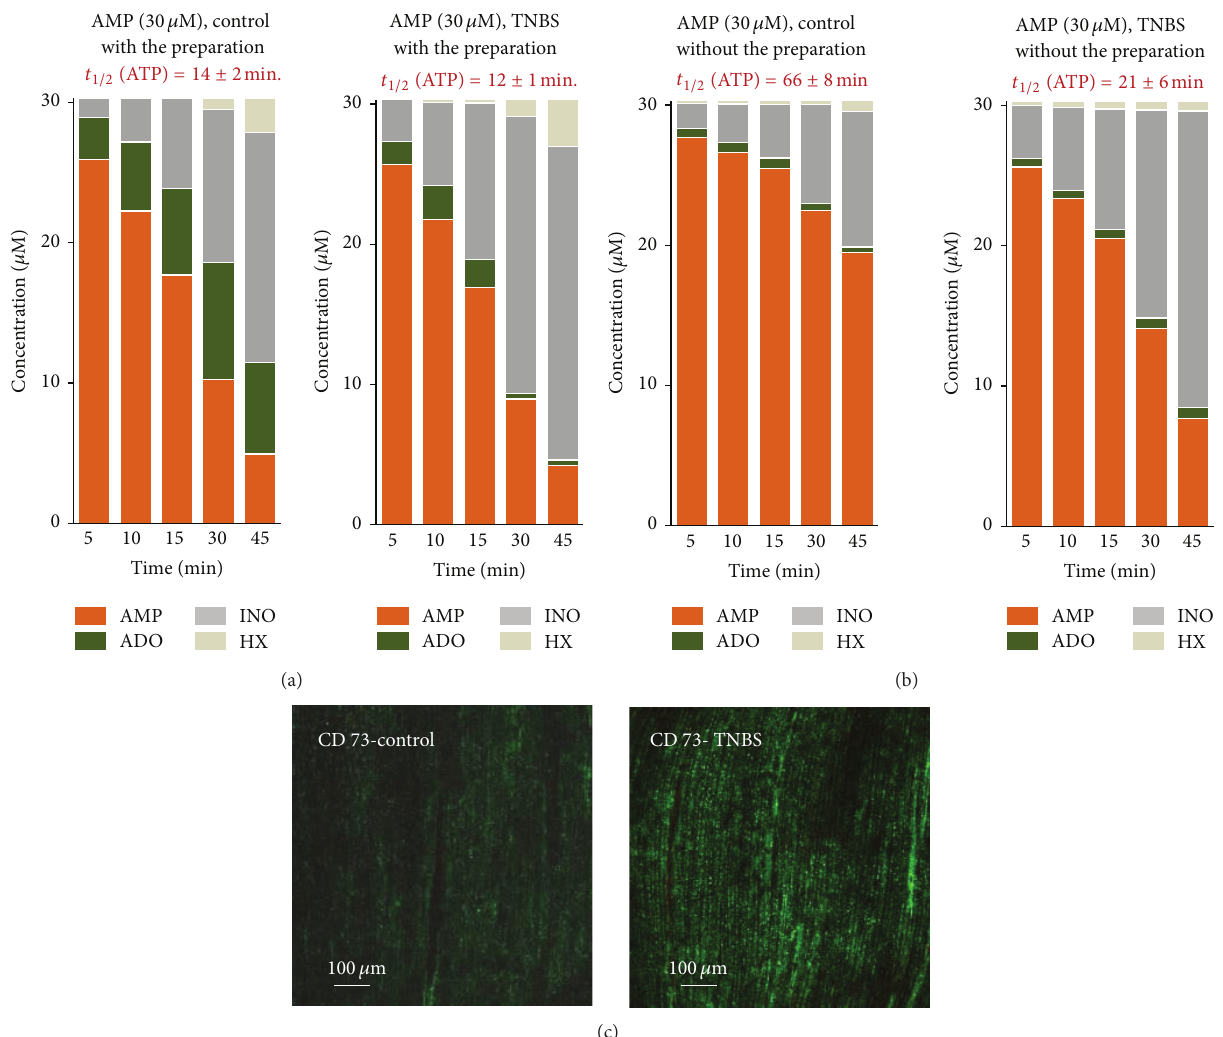
Figure6:KineticsoftheextracellularcatabolismAMP(30 𝜇 M)intheLM-MPoftheileumofcontrolandTNBS-injectedrats(a).Theresidual ecto-5 󸀠 -nucleotidase/CD73 activity (soluble form) in the incubation fluid after removing the preparations from the organ bath, is also shown (b). AMP (30 𝜇 M) was incubated at zero time (see Section 2). Collected samples were analysed by HPLC with UV detection to separate and quantify AMP (orange), ADO (green), INO (dark grey) and HX (light grey). Average results obtained in four experiments. Panel (c) shows that immunoreactivity against ecto-5 󸀠 -nucleotidase/CD73 in longitudinal smooth muscle fibers of the ileum from TNBS-treated rats is much more evident than in control